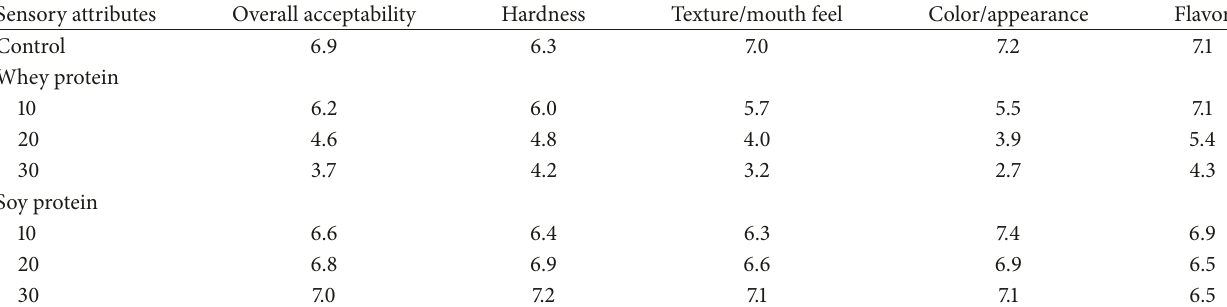
Table 3: Consumer acceptability (9-point hedonic scale)